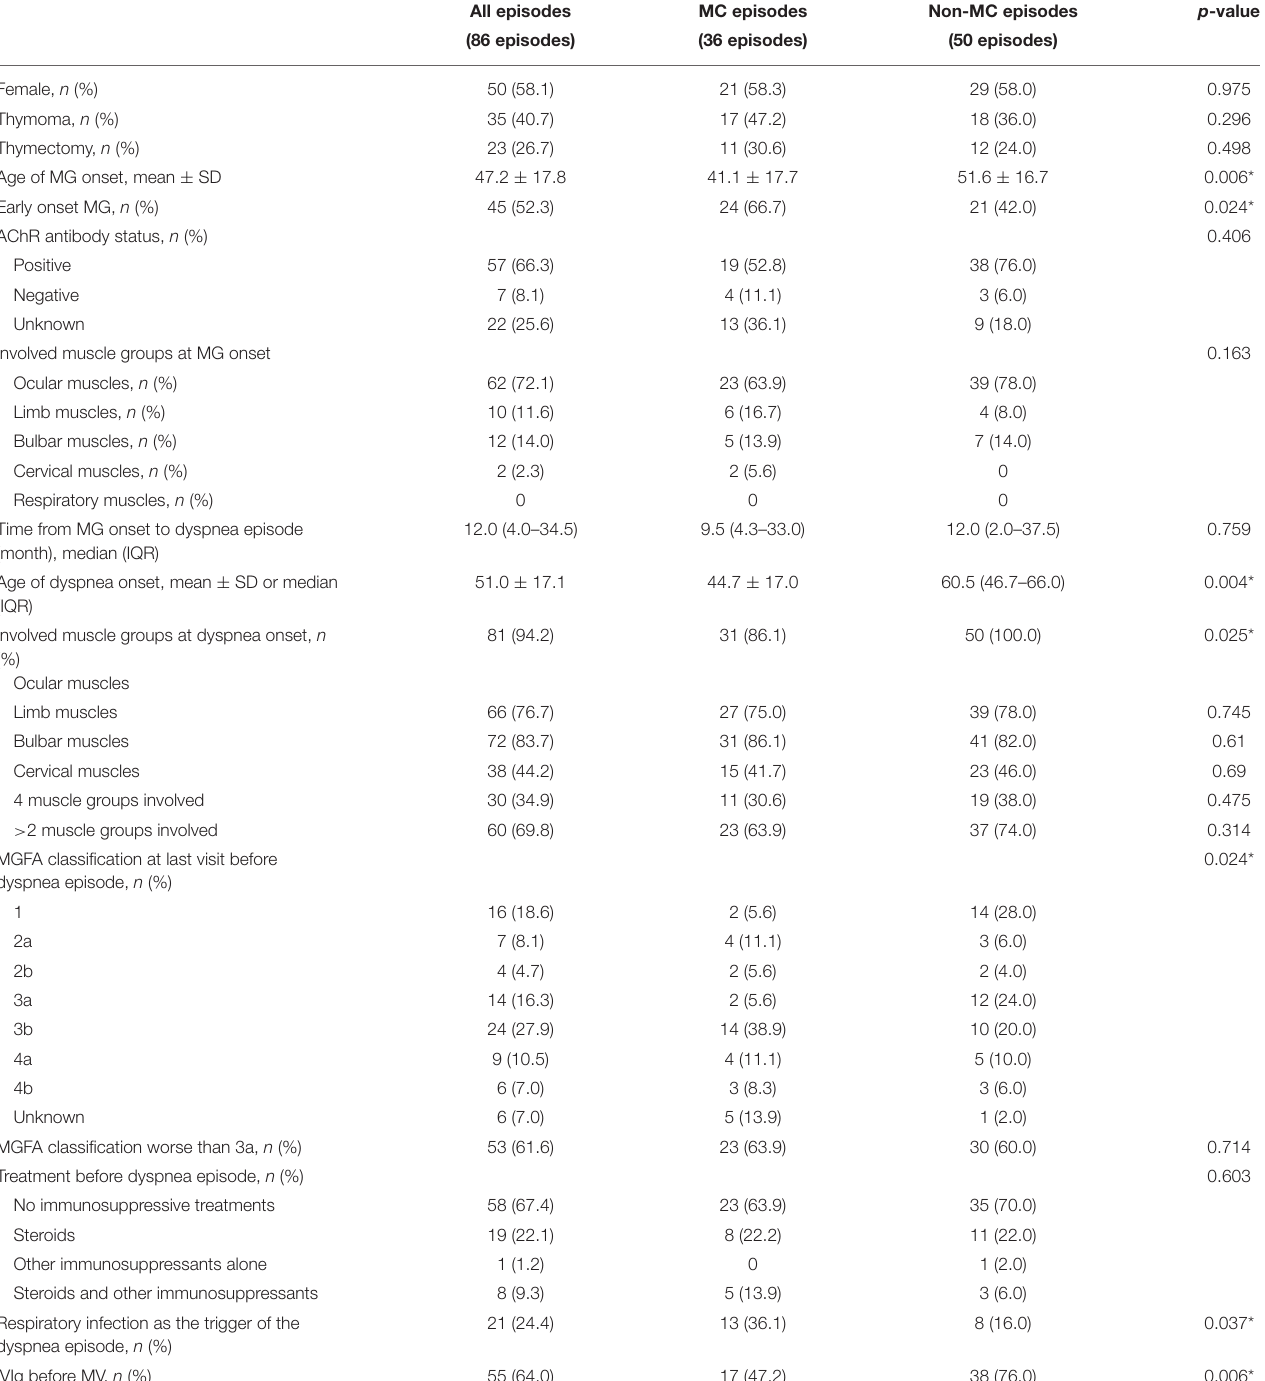
TABLE 1 | The baseline characteristics of first acute dyspnea episodes of the patients with myasthenia gravis (MG) and comparison between myasthenic crisis (MC) and non-MC